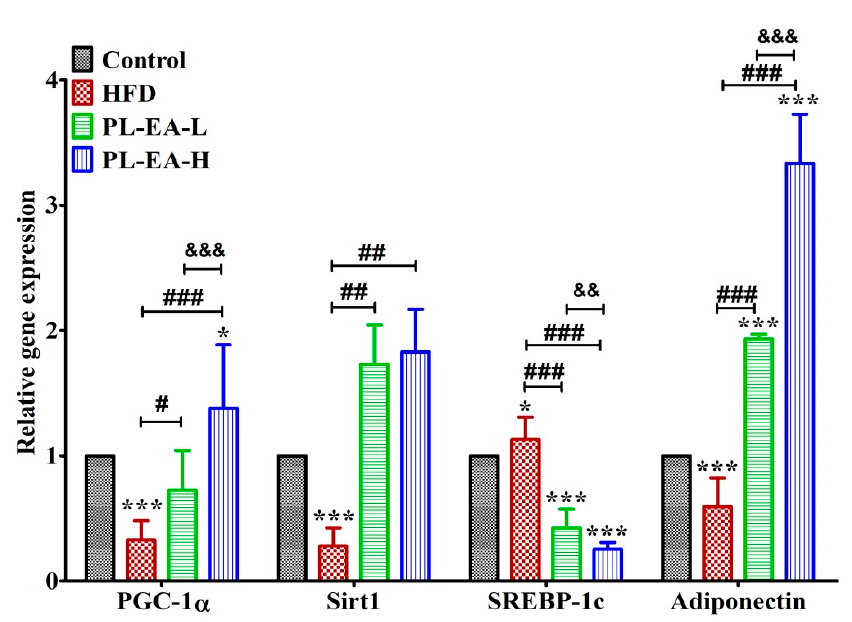
Figure 9. Effects of ethyl acetate fraction from P . linteus mycelia on the relative gene expression of mice livers. HFD: high-fat/high-fructose diet (HFD). PL-EA-L: HDF + low dose PL-EA (35 mg/kg). PL-EA-H: HDF + high dose PL-EA (70 mg/kg). Data are expressed as mean ± SE ( n = 9). * and ***, p < 0.05 and 0.001, respectively vs. the control; # , ## and ### , p < 0.05, 0.01 and 0.001, respectively vs. the O/P group. && and &&& , p < 0.01 and 0.001, respectively, significant differences between the groups. PGC1- α : peroxisome proliferator-activated receptor gamma coactivator 1-alpha; Sirt-1: NAD-dependent deacetylase sirtuin-1; SREBP-1c: sterol regulatory element-binding protein